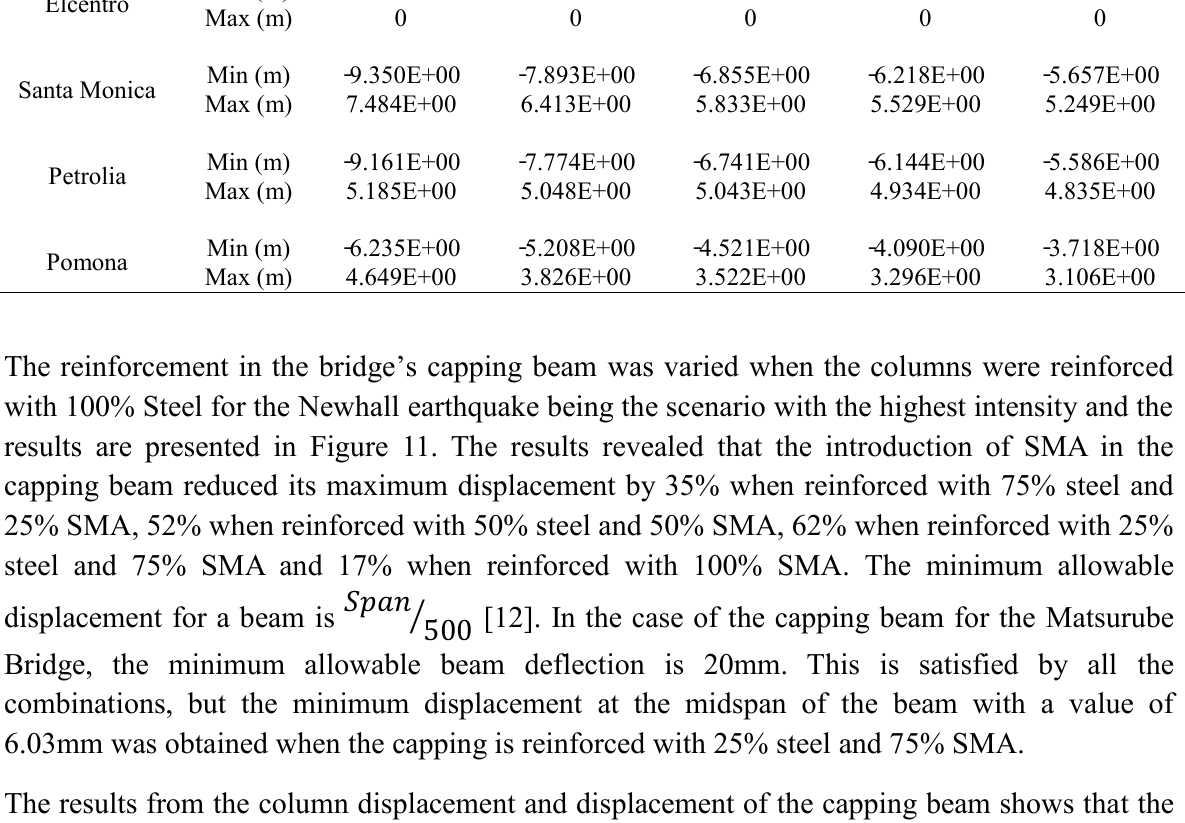
Table 8 Minimum and Maximum Displacements at Joint J2 Earthquakes 100% Steel